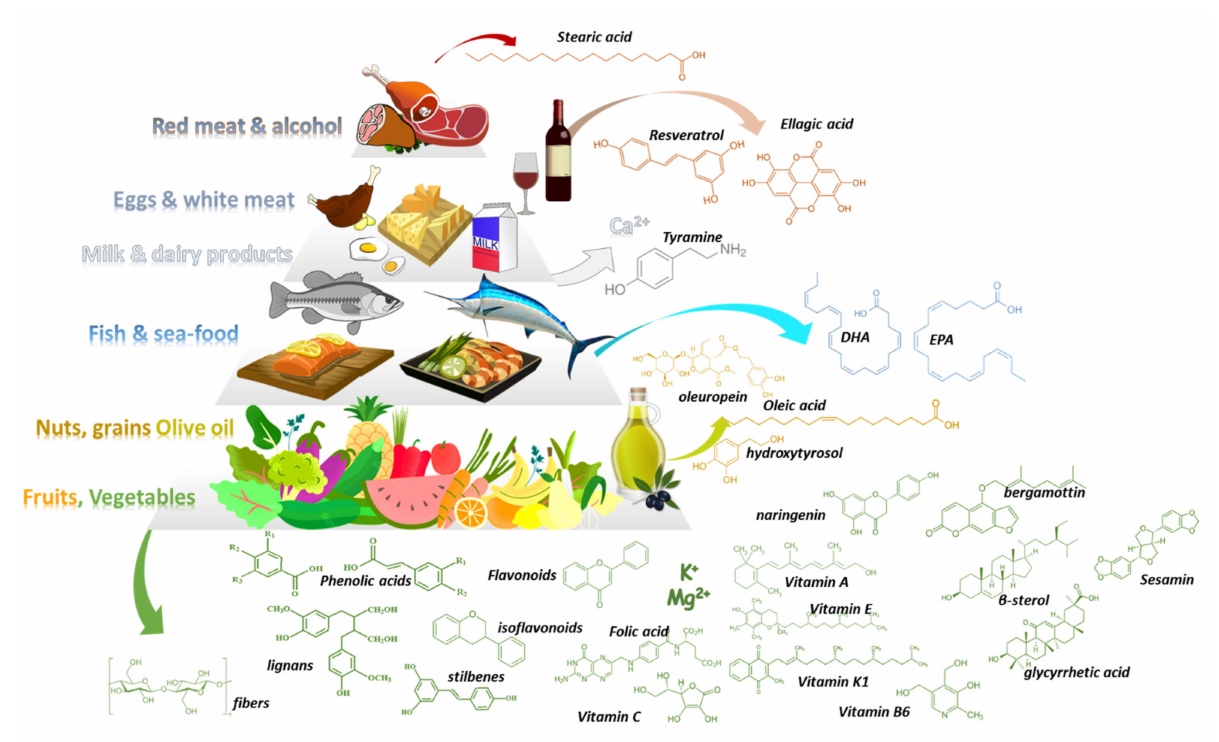
Figure 4. The Mediterranean diet pyramid along with examples of characteristic constituents that can be found in Med-D’s food products. Table 1. DFIs, pharmacological mechanism, significance, and level of evidence for vegetables and herbs that are contained in the base of Med-D pyramid (PK: pharmacokinetic, PD: Pharmacodynamic, DFI: drug-food